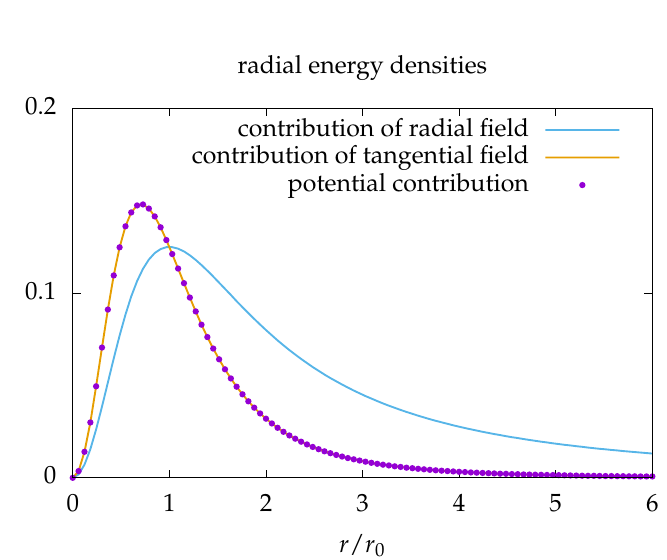
Figure 2. Radial energy densities of the stable soliton solution according to Equation (33). The prefactor in h is